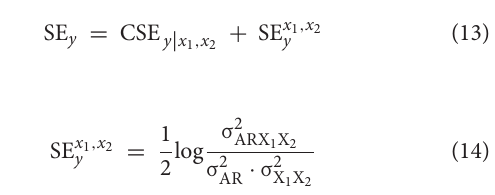
x 1 (yellow area), 1 , x 2 → y (cid:12) (cid:12)